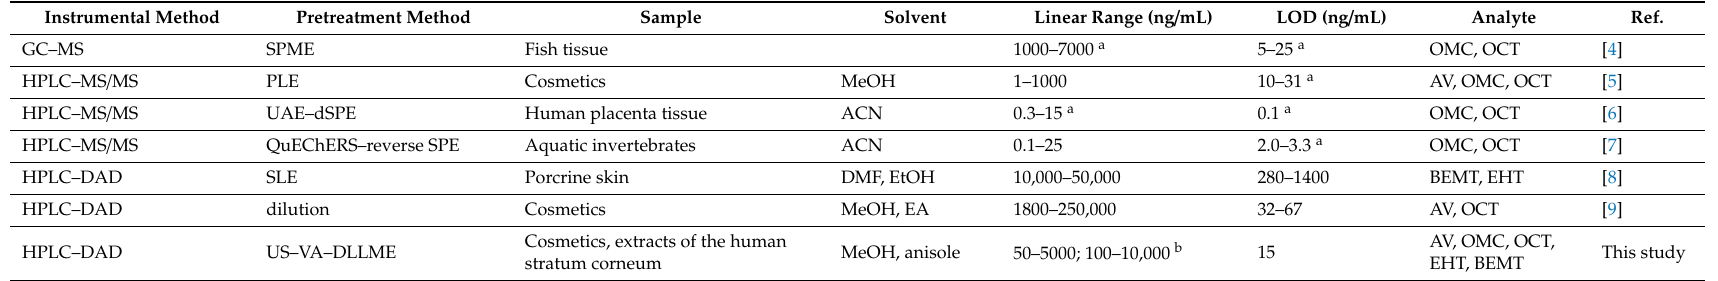
Table 3. Analytical methods for chemical UV filters in cosmetics and biological